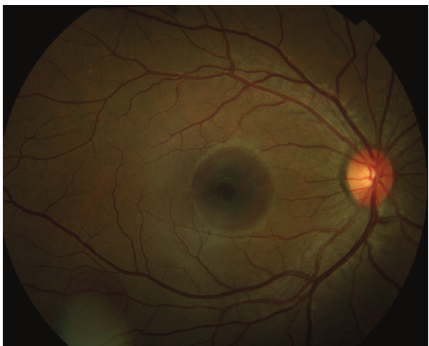
Figure 1: Two small localized subretinal hemorrhages in the right eye, one in the macula and another along the inferotemporal arcade, without any obvious choroidal